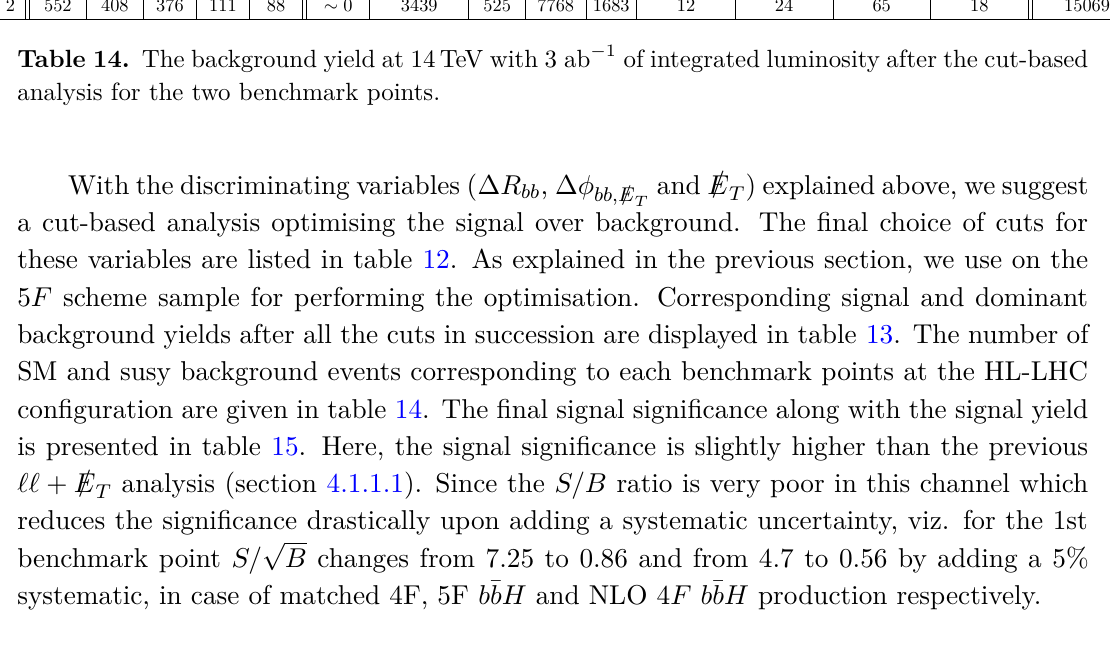
Table 14. The background yield at 14 TeV with 3 ab − 1 of integrated luminosity after the cut-based analysis for the two benchmark